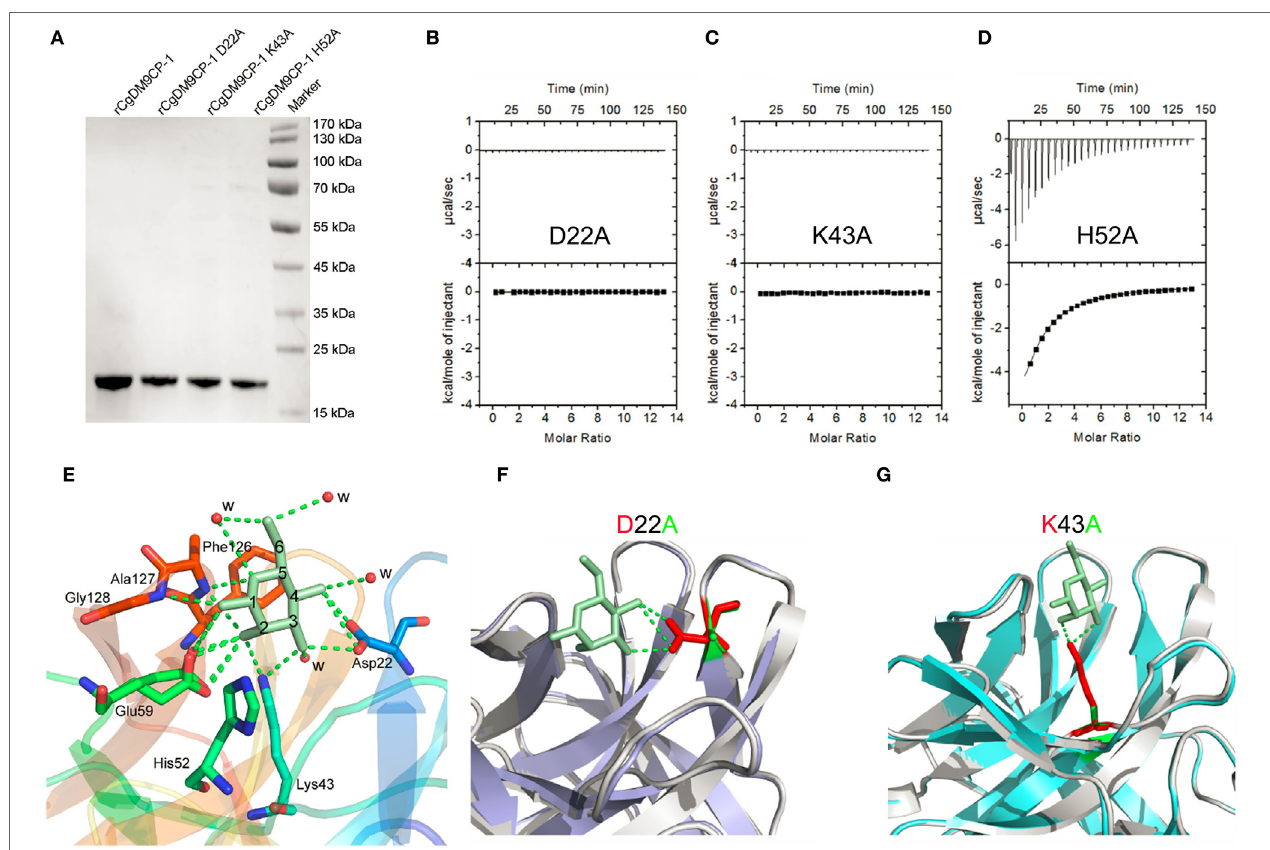
FigUre 2 | The ligand binding capacity of recombinant Crassostrea gigas DM9 domain containing protein 1 (rCgDM9CP-1) and its mutants. (a) Purified rCgDM9CP-1 and mutants were analyzed by SDS-PAGE. Isothermal titration calorimetry (ITC) analysis for d -mannose binding to mutant D22A (B) , K43A (c) , and H52A (D) in PBS buffer at 25°C. The crystal structures of wild-type rCgDM9CP-1 in complex with d -mannose [ (e) , PDB: 5MH1], and the mutants D22A (PDB: 5MH2) and K43A (PDB: 5MH3) are solved. The crystal structures of D22A [ (F) , purple] and K43A [ (g) , cyan] were superimposed with that of wild-type rCgDM9CP-1 (gray) in complex with d -mannose (green), respectively. The d -mannose is represented as cyan stick, and the potential amino acid residues involved in the d -mannose binding are shown. The hydrogen bonds between d -mannose and amino acid side chains are represented as dotted